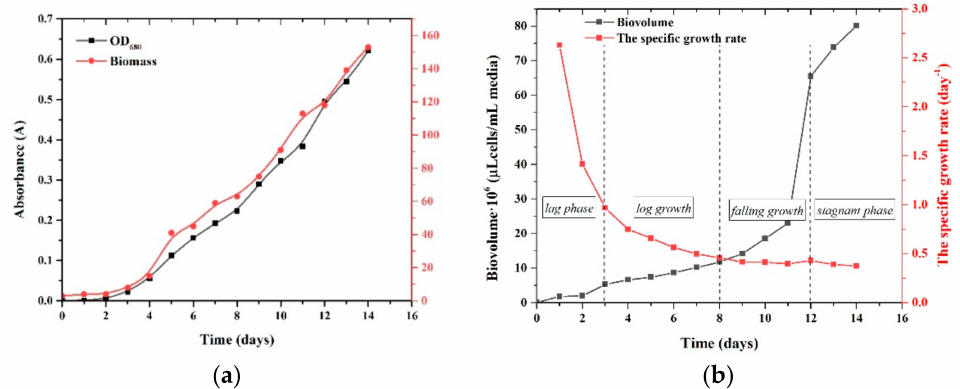
Figure 2. Chlorella vulgaris culture growth curves depending on absorbance at 680 nm and biomass concentration ( a ) and by biovolume and specific growth rate ( b ).